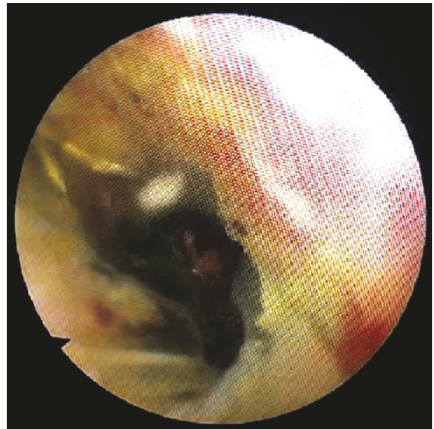
Figure 3: Choledochoscopic view of distal CBD. Large stone is seen within impacted ERCP Dormia basket.